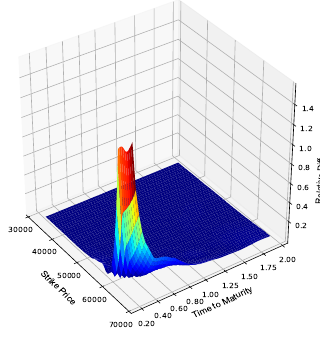
Figure 8. JSE Top 40 fully collateralized call